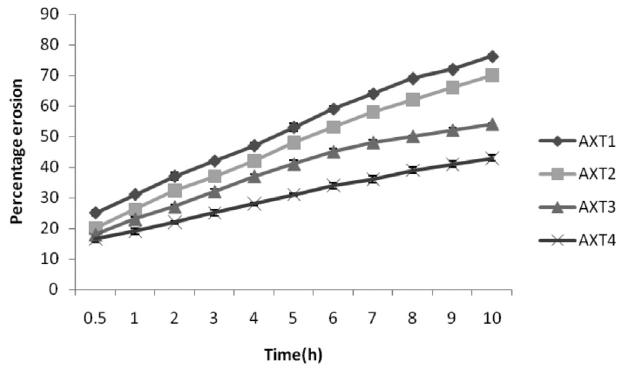
FIGURE 5 - Cumulative percentage drug release of fromulations (AXT 1 to AXT 4) in